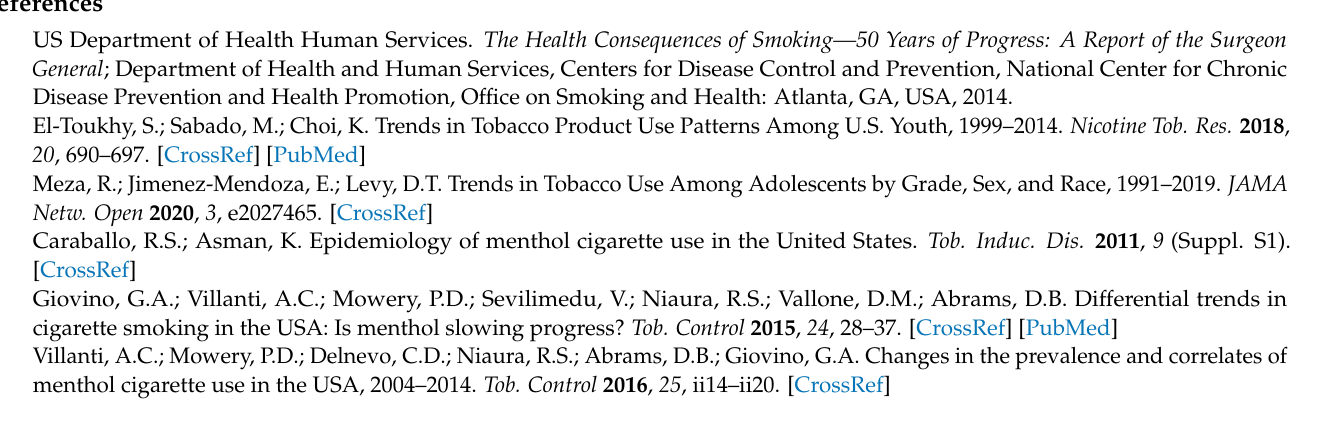
Figure S1: Prevalence of exclusive and dual use of ENDS and menthol/non-menthol cigarettes overall, Figure S2: Prevalence of exclusive and dual use of ENDS and menthol/non-menthol cigarettes by sex, Figure S3: Prevalence of exclusive and dual use of ENDS and menthol/non-menthol cigarettes overall by household income (PATH only), and Figure S4: Prevalence of exclusive and dual use of ENDS and menthol/non-menthol cigarettes overall by homeownership (PATH